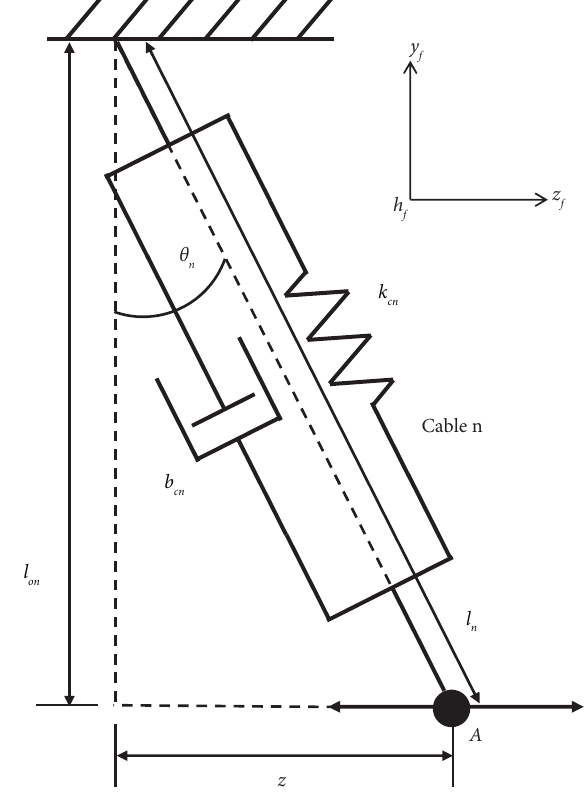
Figure 3: Diagram of the variables involved in the out-of-plane